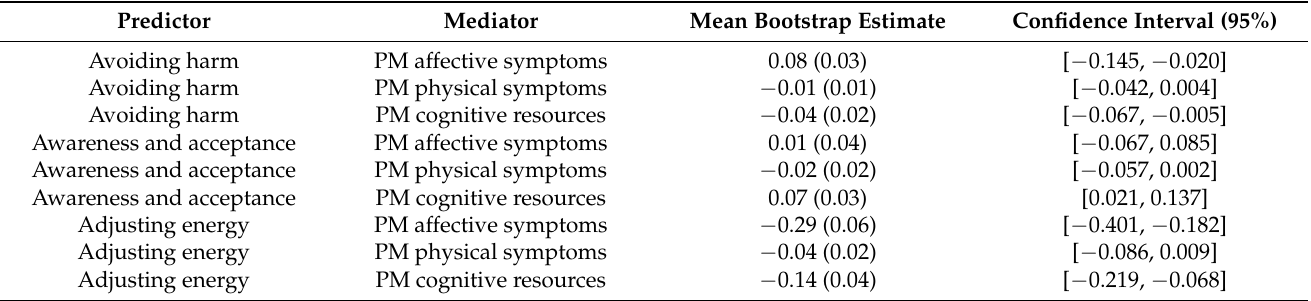
Table 4. Indirect effects in Model 2 with well-being as the dependent